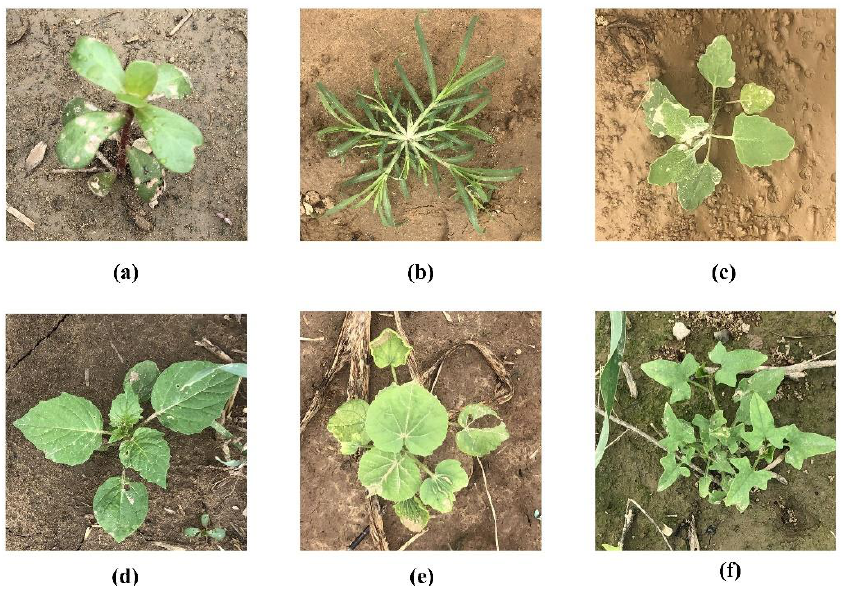
Figure 1. Shape and color of six weeds. ( a ) Portulaca oleracea, ( b ) Eleusine indica, ( c ) Chenopodium album, ( d ) Amaranth blitum, ( e ) Abutilon thophrasti, ( f ) Calystegia hederacea.